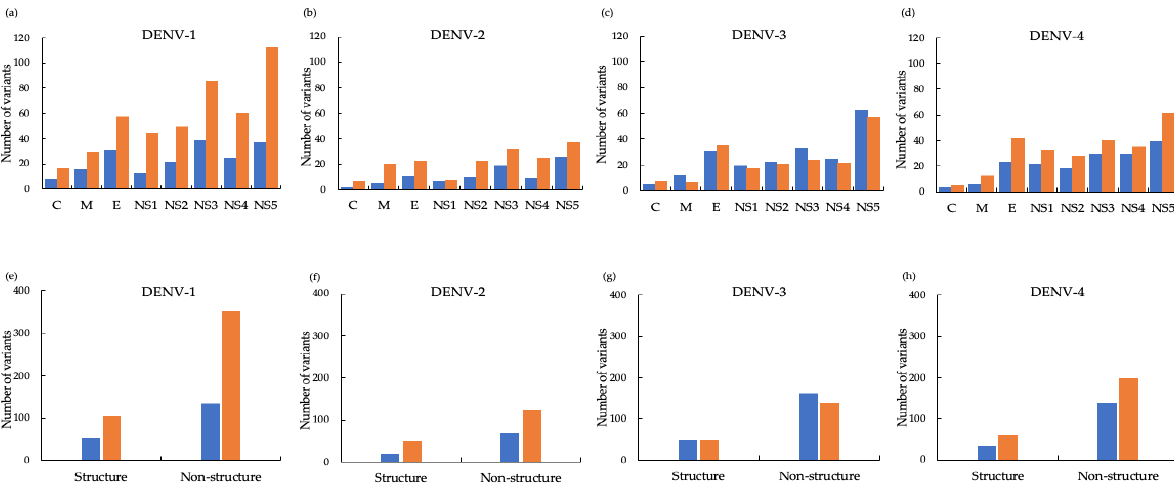
Figure 6. Amino acid variants of DENV-1–4 co-circulating in Yangon, Myanmar between 2017 and 2019. ( a – d ) Number of variants harboring synonymous (blue) and non-synonymous (orange) amino acid changes in the capsid ( C ), membrane- associated ( M ), envelope ( E ), and non-structural (NS1–5) proteins of ( a ) DENV-1, ( b ) DENV-2, ( c ) DENV-3, and ( d ) DENV-4. ( e – h ) Total number of variants with amino acid changes in structural ( C , M , E ) and non-structural (NS1–5) proteins. In total, 452 and 184, 169 and 82, 185 and 206, and 254 and 168 non-synonymous (orange) and synonymous (blue) variants, respectively, were identified for DENV-1, DENV-2, DENV-3, and DENV-4, respectively. For DENV-1, the number of NSY and SY variants in non-structural proteins was 350 and 132, respectively, compared with 102 and 52, respectively, in the structural proteins. The three most frequently mutated proteins for DENV-1 were NS5 (NSY 112, SY 37), followed by NS3 (NSY 85, SY 38), and E (NSY 57, SY30). Similarly, more DENV-2 variants harbored NSY than SY changes and more changes affected non-structural proteins (NSY 121 and SY 66, respectively) than structural proteins (NSY 48 and SY 16, respectively). The most frequently mutated DENV-2 proteins were NS5 (NSY 37, SY 25), NS3 (NSY 31, SY 18), and E (NSY 22, SY 10). For DENV-3, the total number of NSY and SY variants in non-structural proteins was 137 and 159, respectively, and in structural proteins was 48 and 47, respectively. The most frequently mutated DENV-3 proteins were NS5 (NSY 56, SY 62), E (NSY 35, SY 30), and NS3 (NSY 23, SY 32). Finally, for DENV-4, the total number of NSY and SY variants in non-structural proteins was 196 and 136, respectively, and in structural proteins was 58 and 32, respectively. The most frequently mutated were NS5 (NSY 61, SY 39), E (NSY 40, SY 23), and NS3 (NSY 40, SY